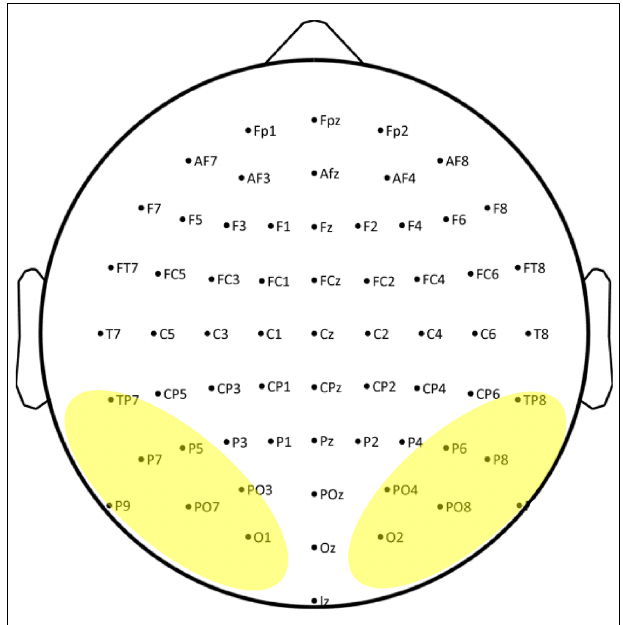
FIGURE 1 | Electrode sites across the scalp used in the current study. Electrodes used in the analyses are indicated by